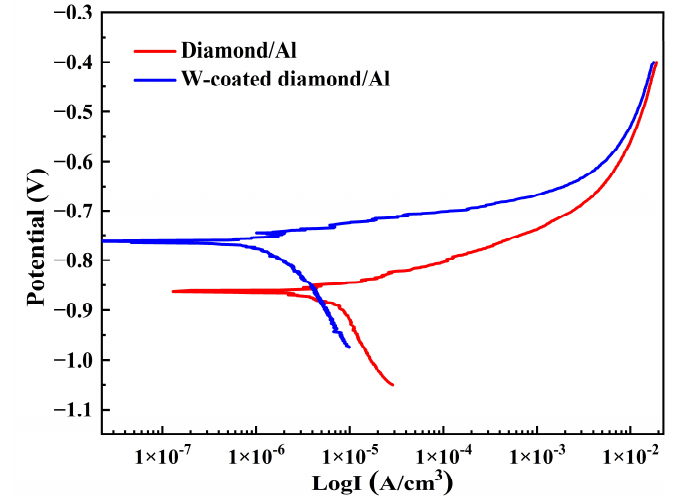
Figure 5. Polarization curve of diamond/aluminum composite.